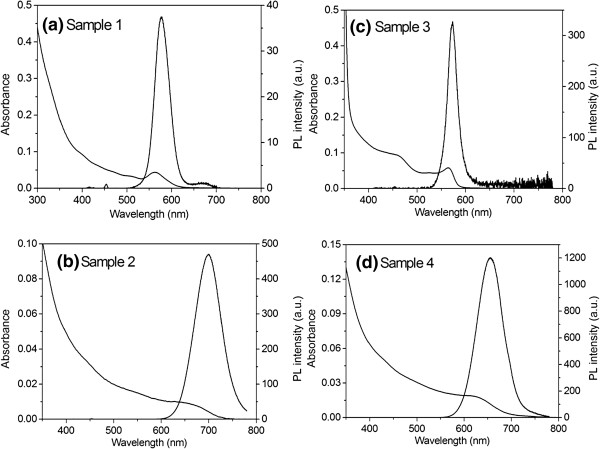
Absorption and PL spectra of CdTe0.5Se0.5cores and CdTe0.5Se0.5/Cd0.5Zn0.5S core/shell QDs shown in Table2. (a) Sample 1 (CdTe0.5Se0.5 cores), (b) sample 2 (CdTe0.5Se0.5/Cd0.5Zn0.5S Core/shell QDs), (c) sample 3 (CdTe0.5Se0.5/Cd0.5Zn0.5S core/shell QDs), and (d) sample 4 (CdTe0.5Se0.5/Cd0.5Zn0.5S Core/shell QDs). Samples 2 and 4 were prepared by using samples 1 and 3, respectively.